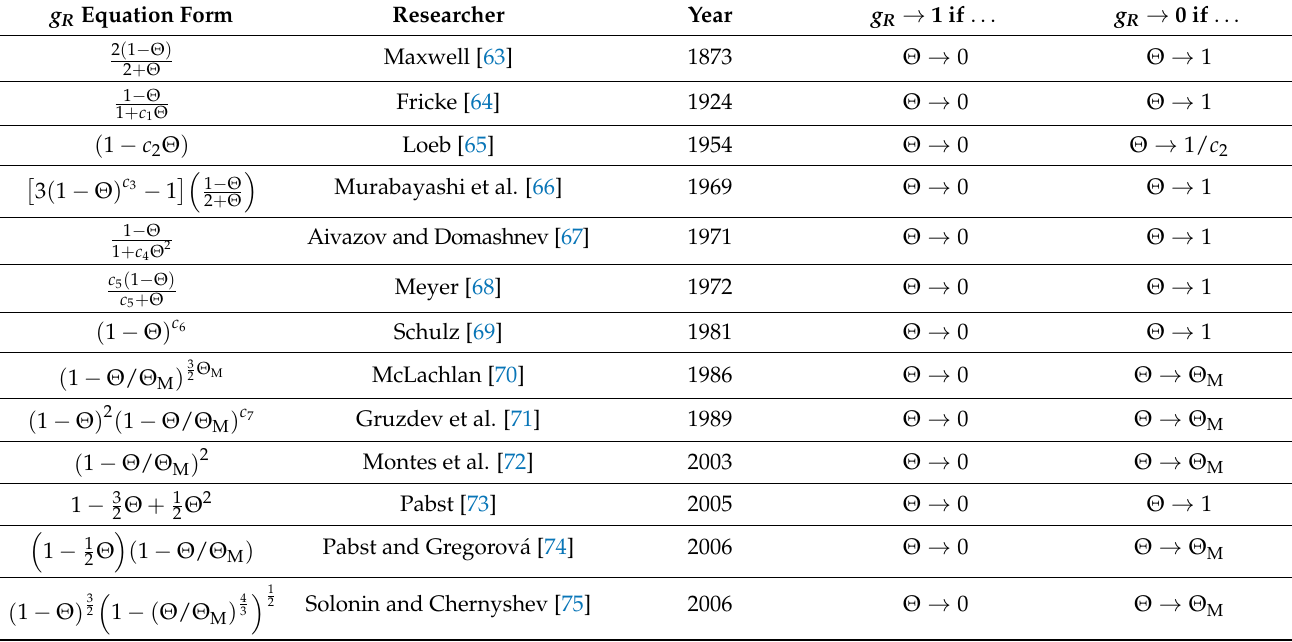
Table 3. Different expressions for the relative conductivity (electrical or thermal) of porous materials ( g R = g / g 0 ) as a function of the compact porosity ( Θ ). Θ M is the maximum porosity of the powder mass, and the remainder parameters c 1 to c 7 are fitting